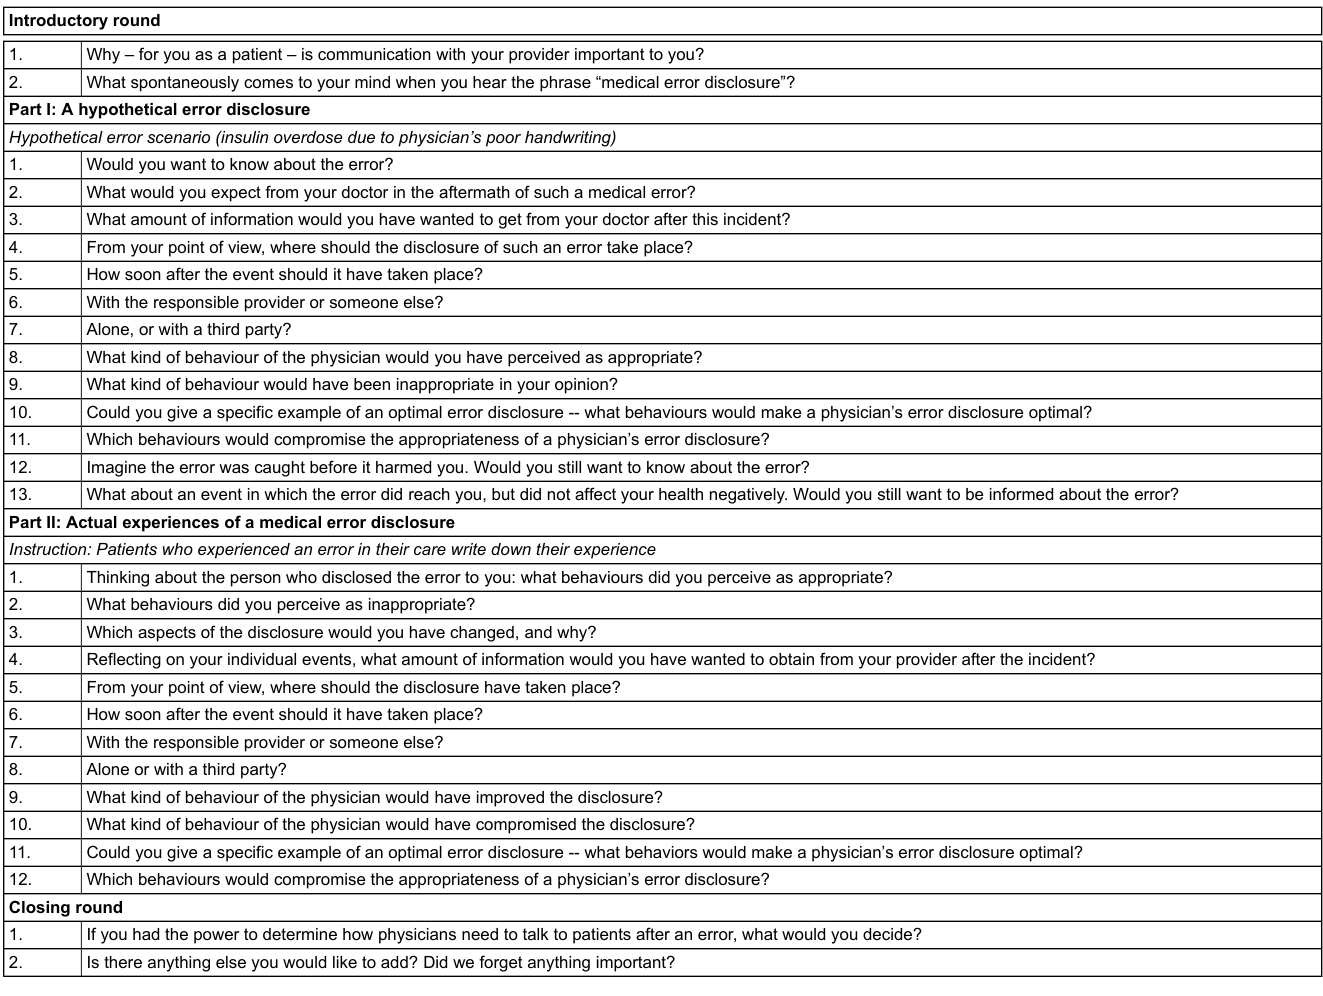
Table 1: Standardised focus group interview